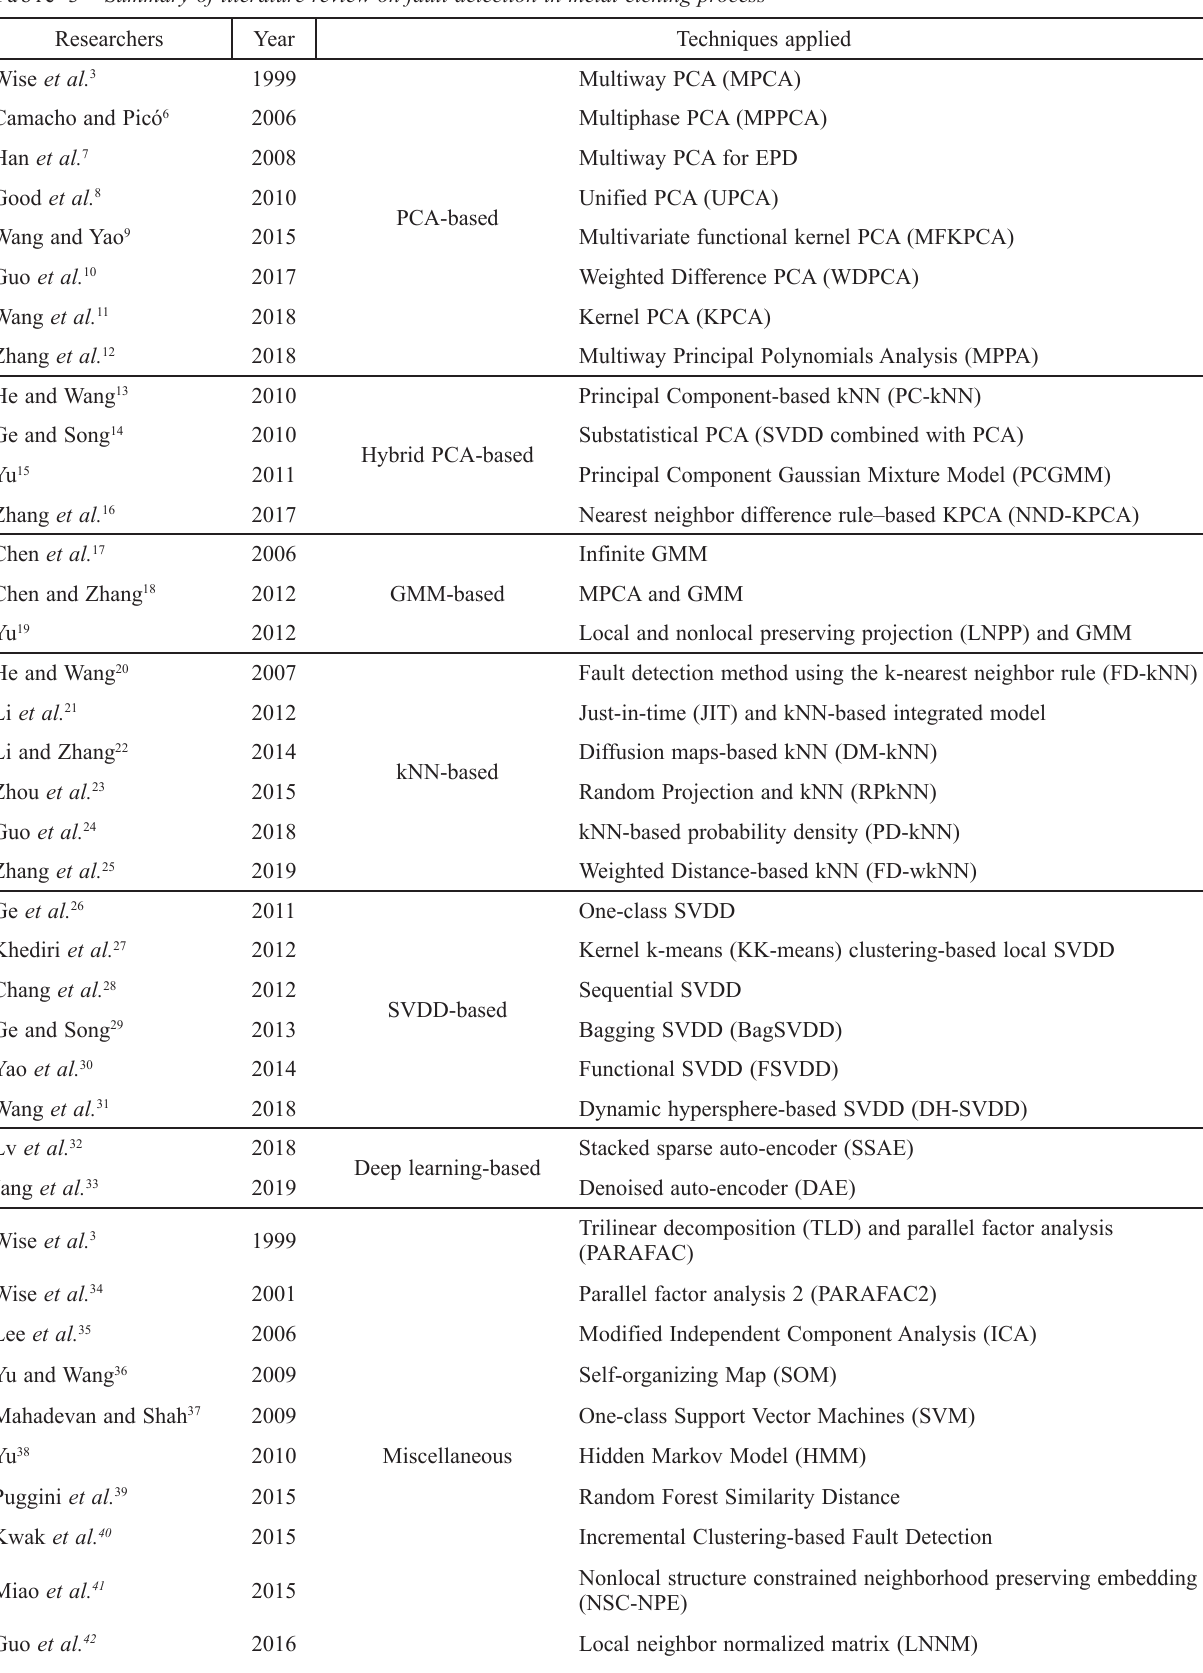
Table 3 – Summary of literature review on fault detection in metal etching process